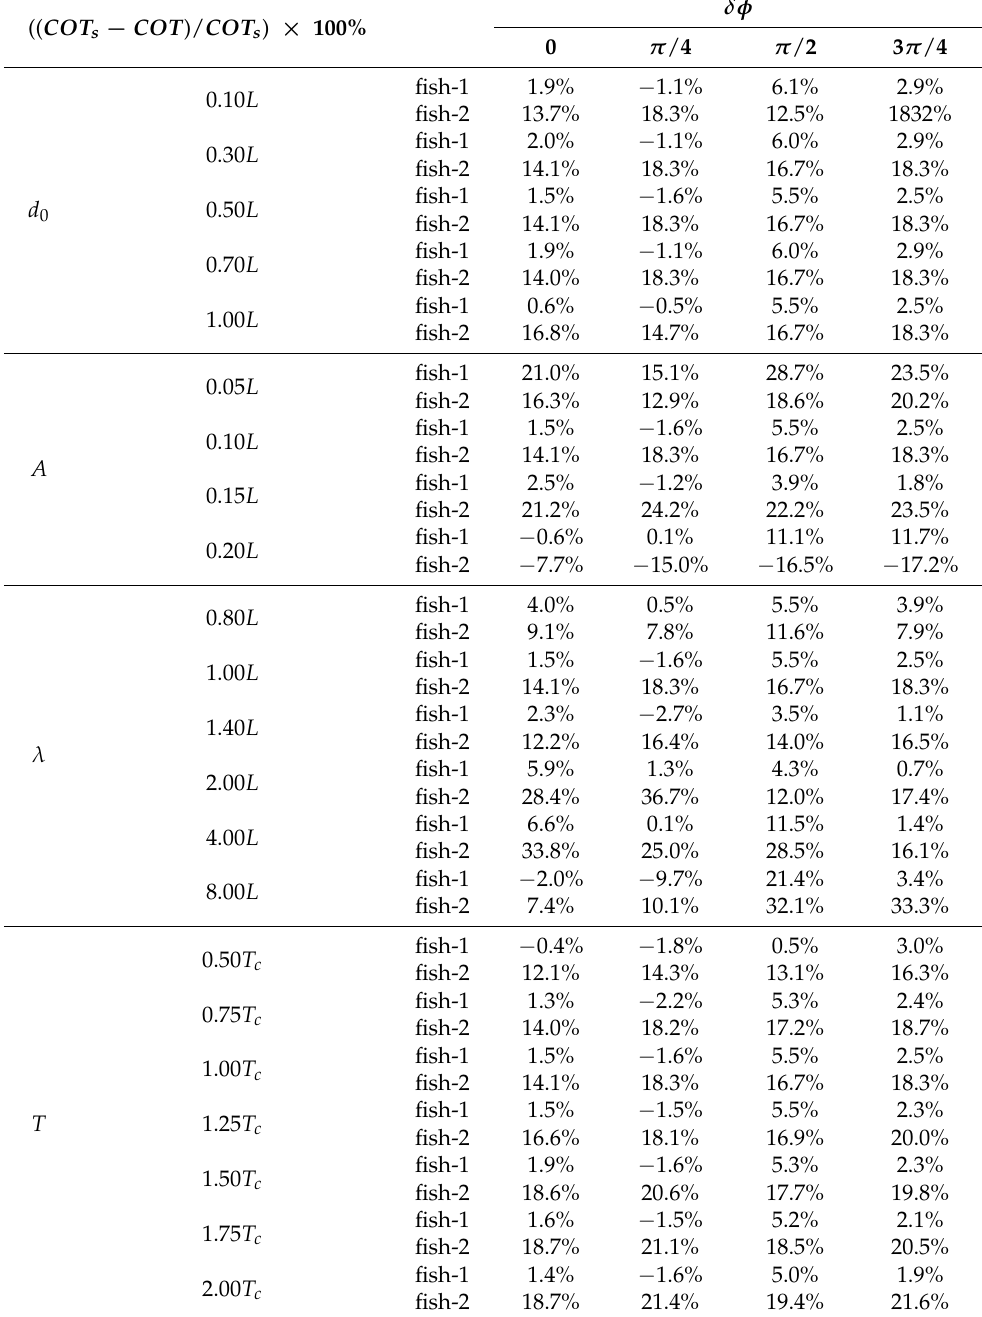
Table 2. The overview of energy-saving efficiency with all studied